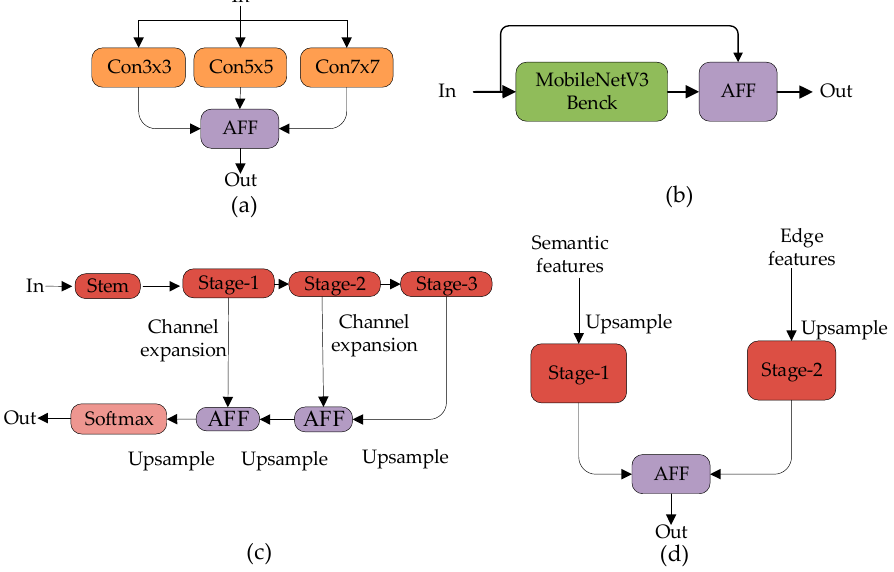
Figure 16. Four different joining positions. ( a ) corresponds to position I in Figure 15, adding AFF to the improved HED network; ( b ) corresponds to position II in Figure 15, adding AFF to the encoder MobileNetV3 network; ( c ) corresponds to position III in Figure 15, adding AFF to the PSP-Net decoder; ( d ) corresponds to position IV in Figure 15, adding AFF to the fusion of semantic features and edge features.